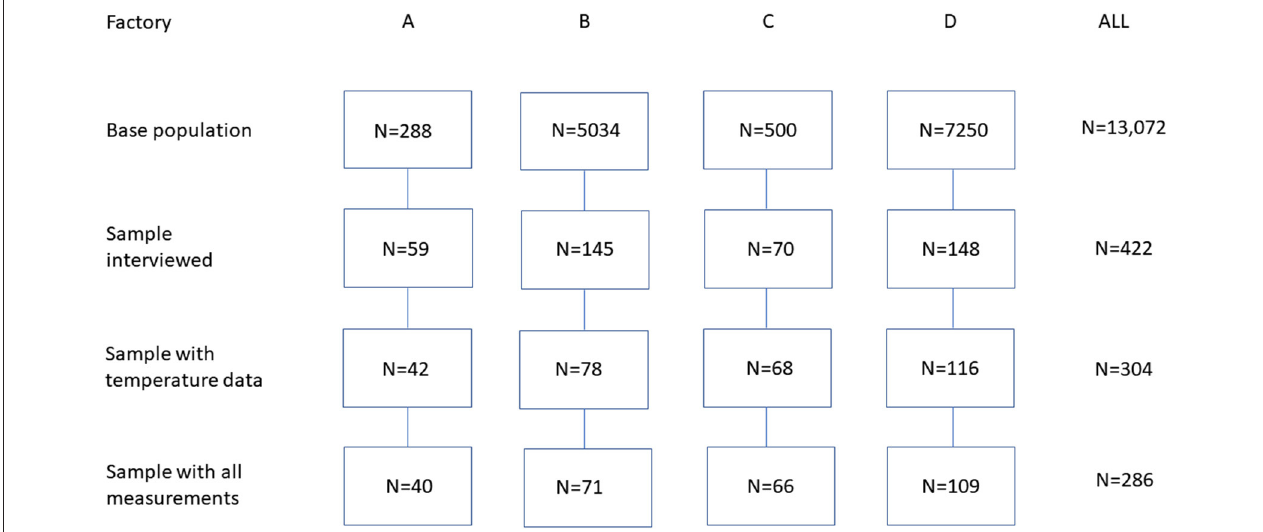
FIGURE 1 | Flowchart of the participant sampling scheme.